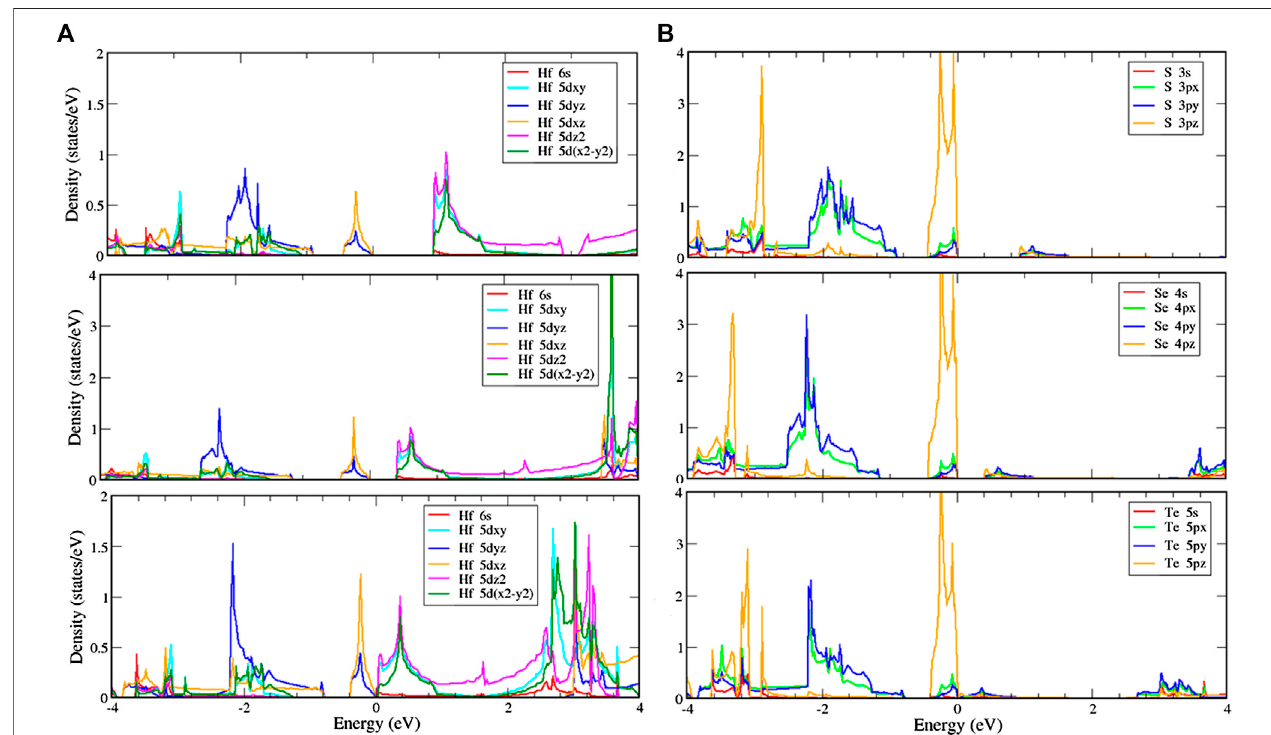
FIGURE 7 | Local density of states (LDOS) of (A) hafnium and (B) chalcogen atoms with multi-orbital hybridization in the H phase.